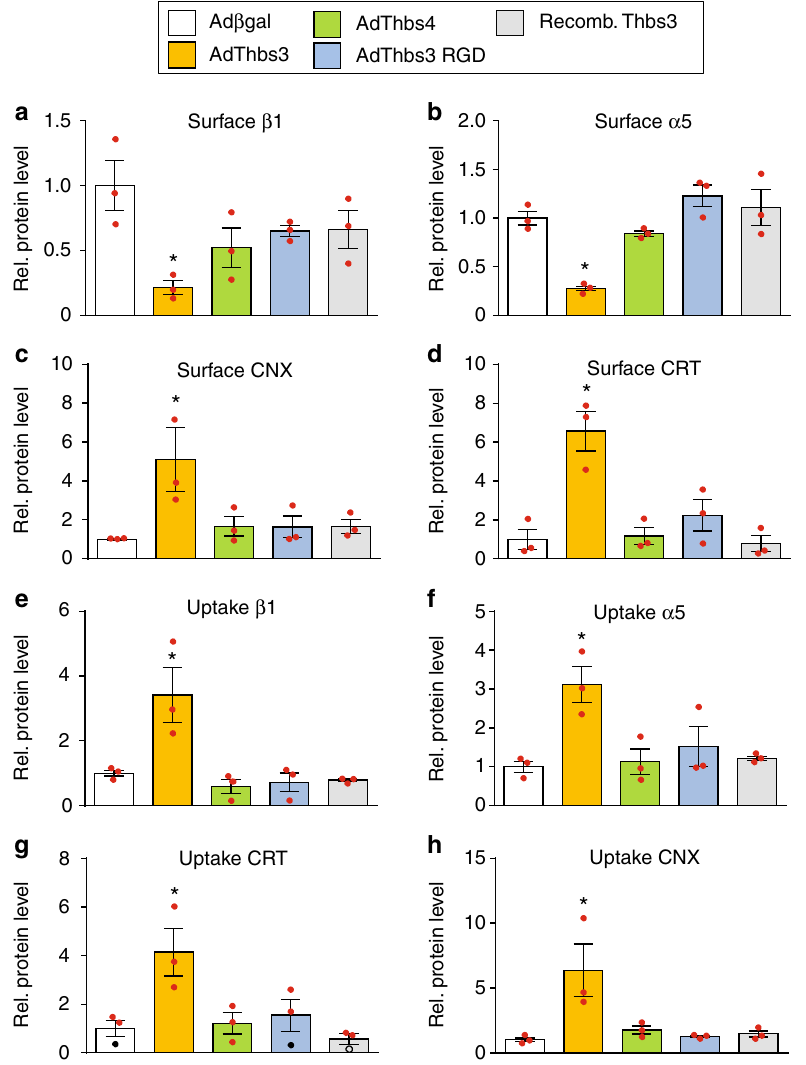
Fig. 8 Thbs3 enhances integrin turnover. a – h Cell surface biotinylated proteins were used for input control experiments or immunoprecipitated with streptavidin (Surface, a – d ) and endocytic protein uptake was induced for 30 min followed by immunoprecipitation with streptavidin (Uptake, e – h ). Quantitative analysis of protein band intensities of β 1D integrin, α 5 integrin, calreticulin (CRT), and calnexin (CXN) from NRVMs infected with Ad β gal, AdThbs3, AdThbs4, AdThbs3-RGD adenovirus or treated with recombinant Thbs3 protein (western blots used for quanti fi cation are presented in